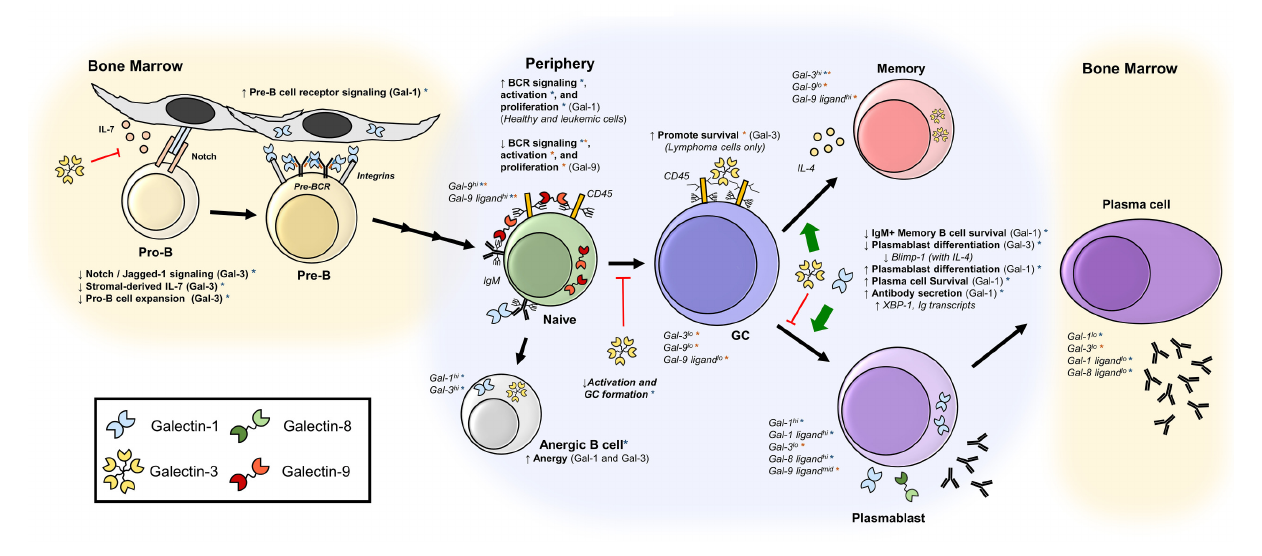
FIGURE 2 | Galectins regulate B cell development, activation, and differentiation. Depicted are published roles of galectins at various stages of differentiation, as well as reported expression of galectins and galectin-binding glycans. Orange asterisks (*) indicate findings described in human B cells, and blue asterisks (*) indicate findings observed in mice. Bone marrow B cells ( 28–34, 37, 60); naïve B cells (38, 43, 45, 56, 57); anergic B cells (37, 68); GC B cells (45, 51); memory B cells (37, 40, 45–50, 58); plasmablasts and plasma cells (37, 39, 59,